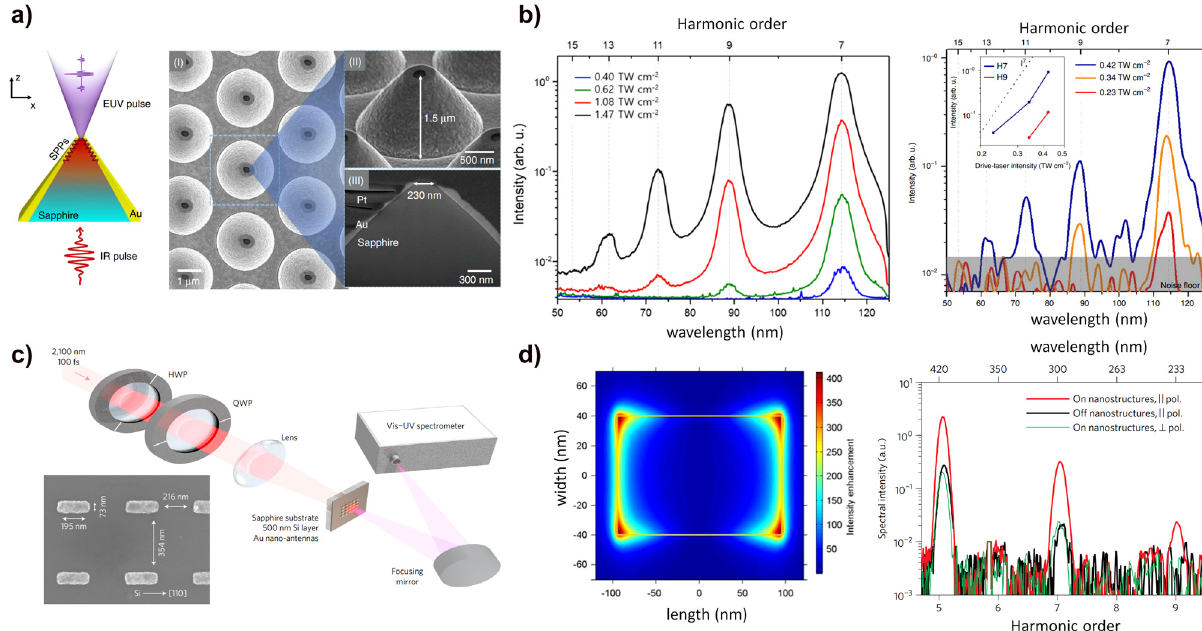
Figure 11: Plasmonically enhanced HHG in solids. (a) Schematic of plasmonically enhanced HHG in an Au-sapphire funnel structure. The SPP propagates along with the Au-sapphire interface and localizes at the tip, which reaches enough intensity for the HHG to happen. The right figure shows the SEM image of the fabricated Au-sapphire funnel structure.(b) HHG spectrum from the bulk c-planesapphire (left)andplasmonic sapphirefunnel structure(right).The plasmonic sapphire funnel structure generates higher-order harmonics (13th order) compared to bulk sapphire (7th order) at a similar input laser intensity ( ∼ 0 . 4 × 10 12 W/cm 2 ) [165]. (c) Schematic of plasmonically enhanced HHG from silicon using an Au nanoantennaarraysetup. SEMimage of anAu nanoantenna array. (d) Numerically computed intensity distribution around the Au nanoantenna at a polarization parallel to the nanoantenna ’ s major axis ( x -direction). The high harmonic spectrum from the Au nanoantenna array with different polarization conditions. The HHG spectrum from the Au nanoantenna array with parallel polarization (red line) and HHG spectrum without the nanoantenna with the same polarization condition (dark blue line). The HHG yields do not increase at the nanoantenna nonresonance condition (green line)